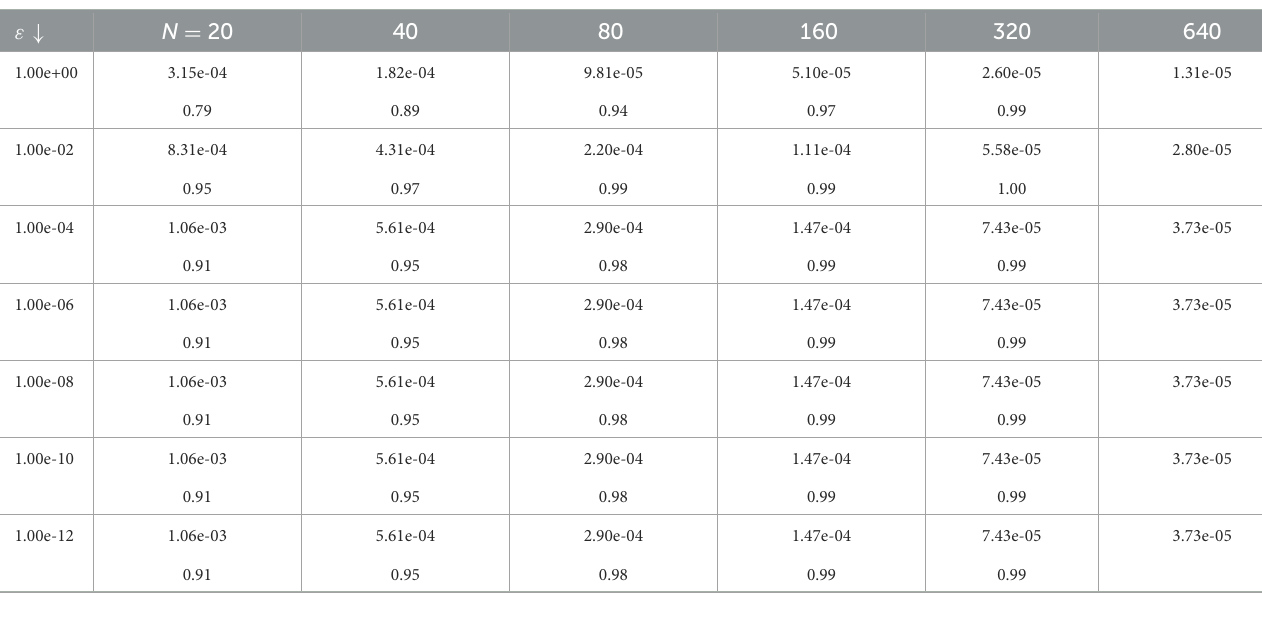
TABLE 1 Maximum absolute errors for Example 4.1 for M = 32 at the number of intervals N